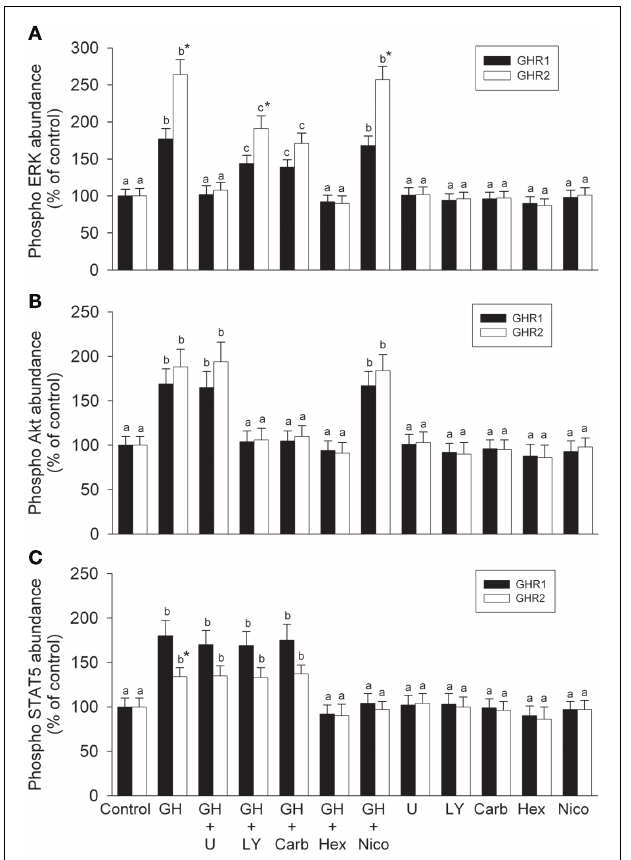
FIGURE 3 | Effects of pathway blockade on growth hormone-induced activation of (A) ERK, (B)Akt, and (C) STAT5. CHO-K1 cells were stably transfected with cDNA encoding rainbow trout GHR1 and GHR2. Transfected cells were pretreated with or without specific inhibitors [10 μ M of the MEK inhibitor, U0126; 20 μ M of the PI3K inhibitor, LY294002 (LY); 25 μ M of the Akt inhibitor, 1L6-hydroxyymethyl-chiro-inositol-2-(R)-2- O - methyl-3- O -octadecyl-sn-glycerocarbonate (Carb); 200 μ M of the STAT5 inhibitor, N (cid:2) -((4-oxo-4H-chroen-3-yl)methylene)nicotinohydrazide (Nico); and 50 μ M of the JAK2 inhibitor, 1,2,3,4,5,6-hexabromocyclohexane (Hex)] for 2h, then treated with or without 100ng/ml growth hormone (GH) for 10min (control is 0ng/ml GH); after which time, the cells were collected and lysed. Cell lysates were separated by SDS-PAGE followed byWestern immunoblotting using phospho-specific (pERK1/2, pAkt, or pSTAT) and total (tERK1/2, tAkt, or tSTAT) antibodies. Data are expressed as percentage of control and are presented as means ± SEM ( n = 8). For a given GHR subtype, groups with different letters are significantly different from each other ( P < 0.05); * designates a significant difference ( P < 0.05) between subtypes within a given treatment.